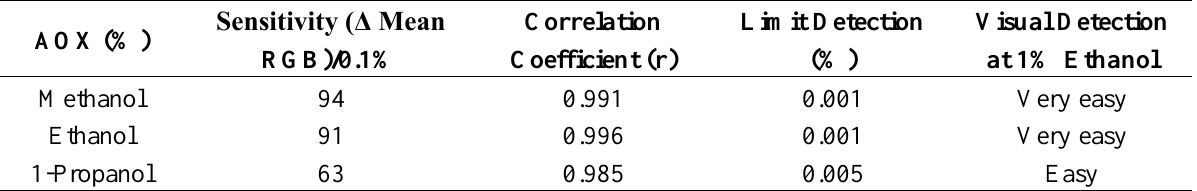
Table 2. Analytical data obtained from calibration curves of AOX/PANI biosensors (0.1% AOX) for three different alcohols under similar experimental